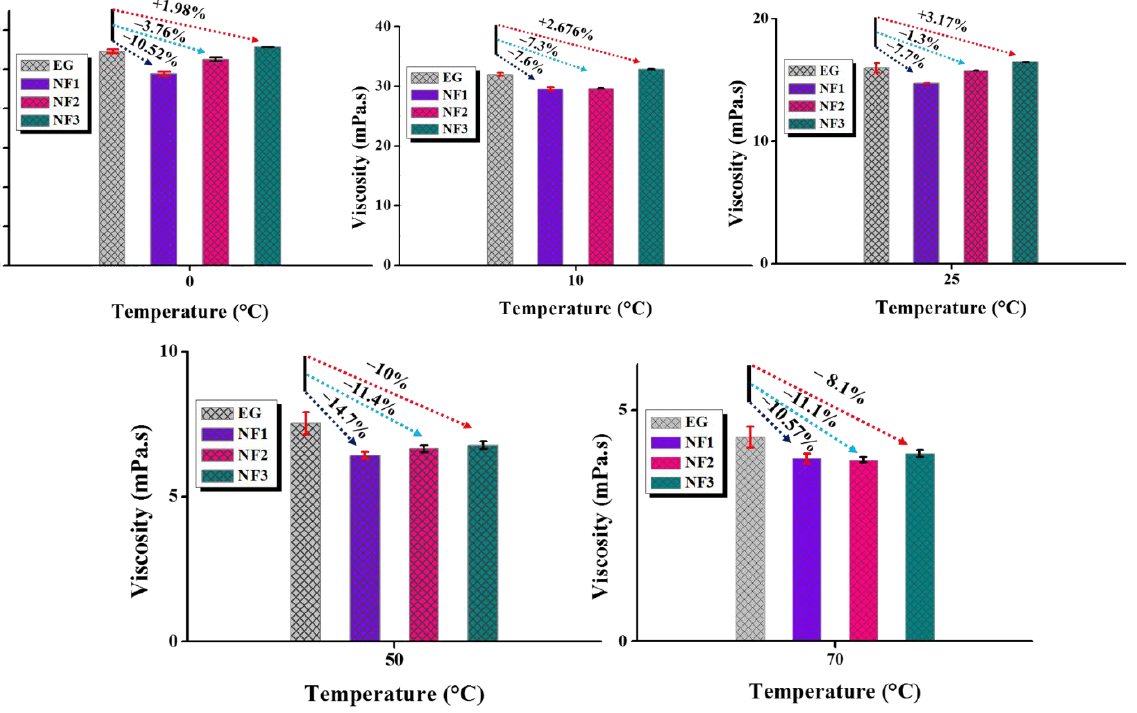
Figure 7. Calculated values of dynamic viscosity using Newton shear stress law and comparison with ethylene glycol (EG) at various steady-state temperatures. Table 4. Dynamic viscosity enhancement/reduction at various temperatures and concentrations (negative sign indicates reduction compared to base fluid).